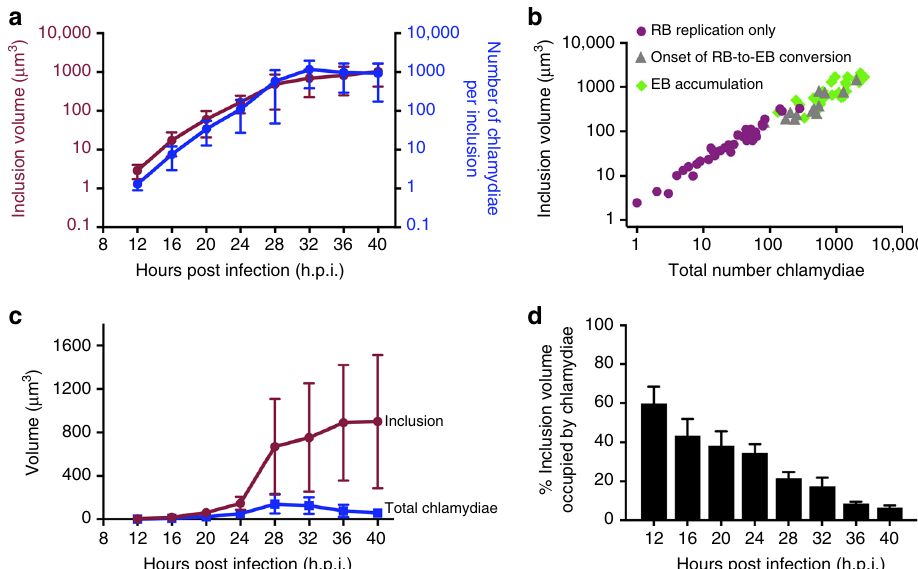
Fig. 2 Volume analysis of the chlamydial inclusion and chlamydial forms during the developmental cycle. The data presented in this fi gure is compiled from a total of 155 inclusions: 12 h.p.i. ( n = 50), 16 h.p.i. ( n = 31), 20 h.p.i. ( n = 22), 24 h.p.i. ( n = 10), 28 h.p.i. ( n = 13), 32 h.p.i. ( n = 10), 36 h.p.i. ( n = 9), 40 h.p.i. ( n = 10). Error bars represent standard deviation. a Temporal change in inclusion volume and number of chlamydiae/inclusion. The data is presented in log scale. b Linear relationship between inclusion volume and total number of chlamydiae within that inclusion. Each dot represents a single inclusion, color- coded by its developmental phase, as described in Fig. 1b. c Temporal change in inclusion volume and total volume of chlamydiae within the inclusion. d % inclusion volume occupied by chlamydiae was calculated for each inclusion as total chlamydial volume divided by inclusion